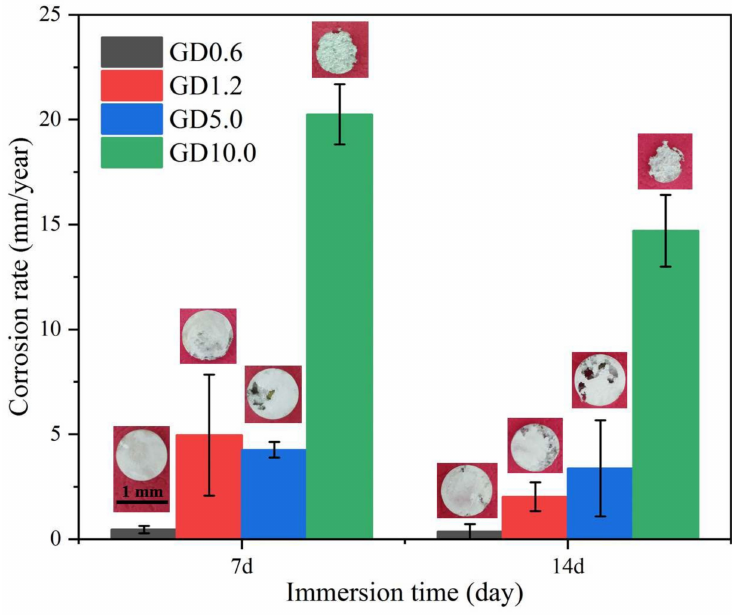
Figure 8. Corrosion rates of as-extruded Mg–Gd–Dy–Zr alloys calculated by mass loss after an immersion of seven days and 14 days,